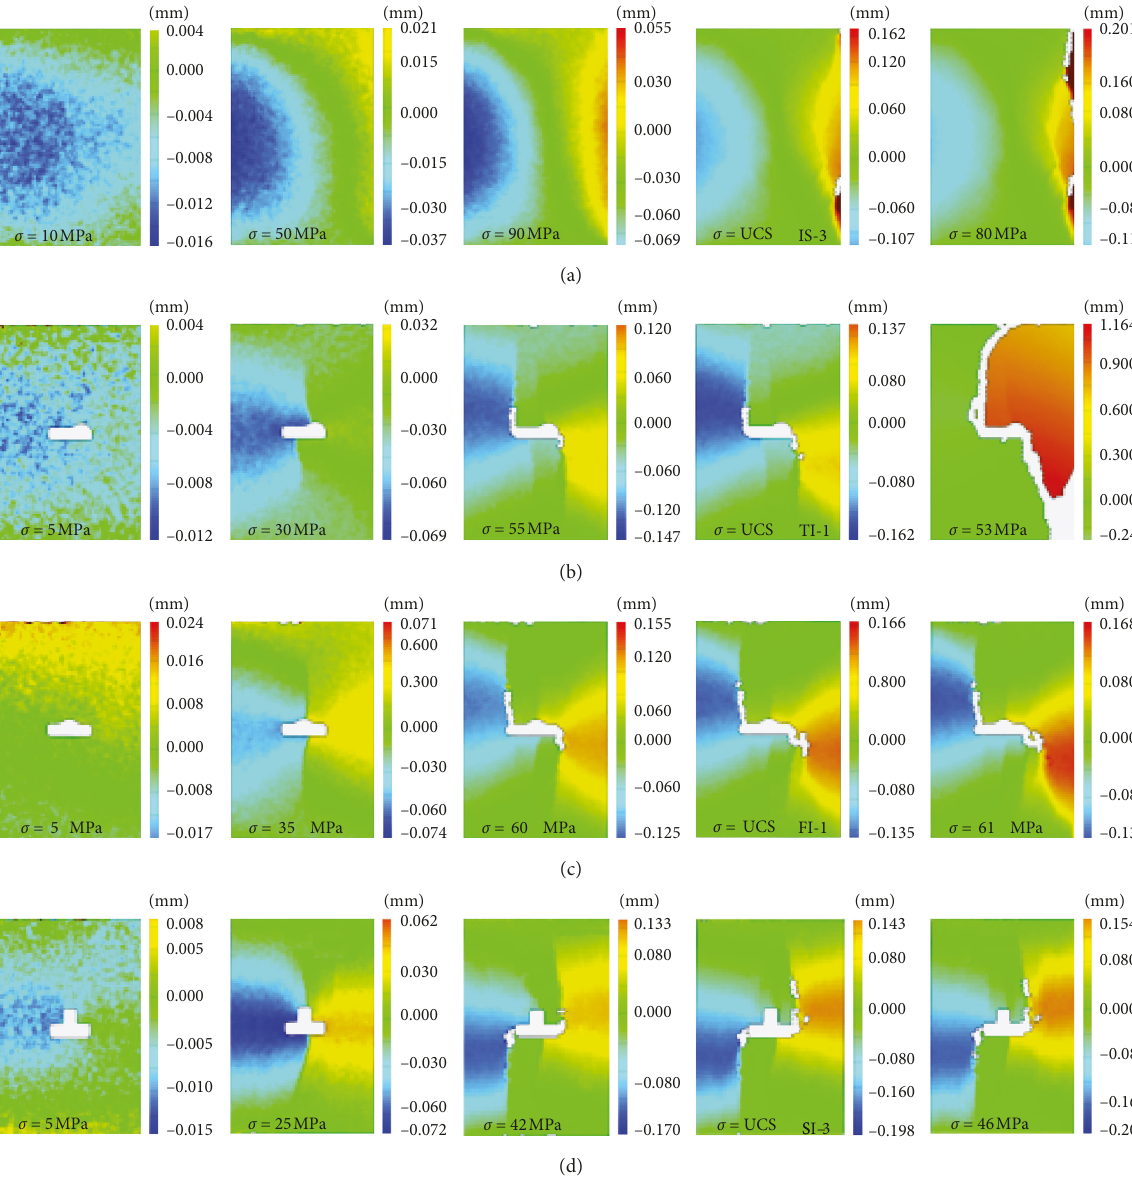
Figure 9: Horizontal displacement contours of four typical specimens at different stress levels: (a) specimen IS-3; (b) specimen TI-1; (c) specimen FI-1; (d) specimen